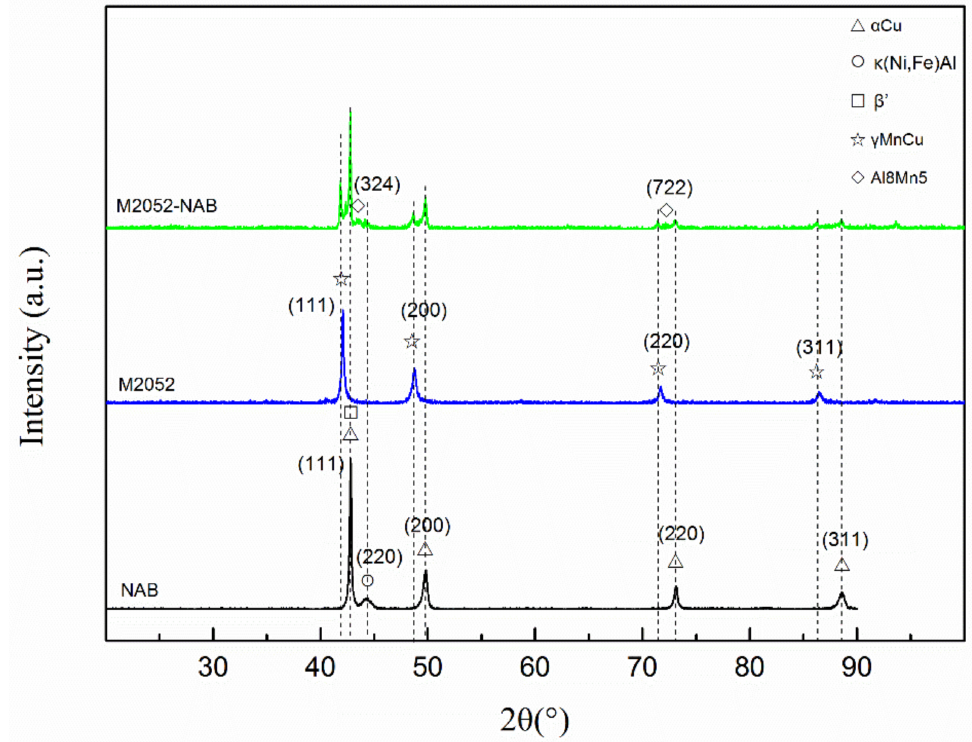
Figure 5. X-ray diffraction patterns of NAB, M2052, and M2052–NAB gradient